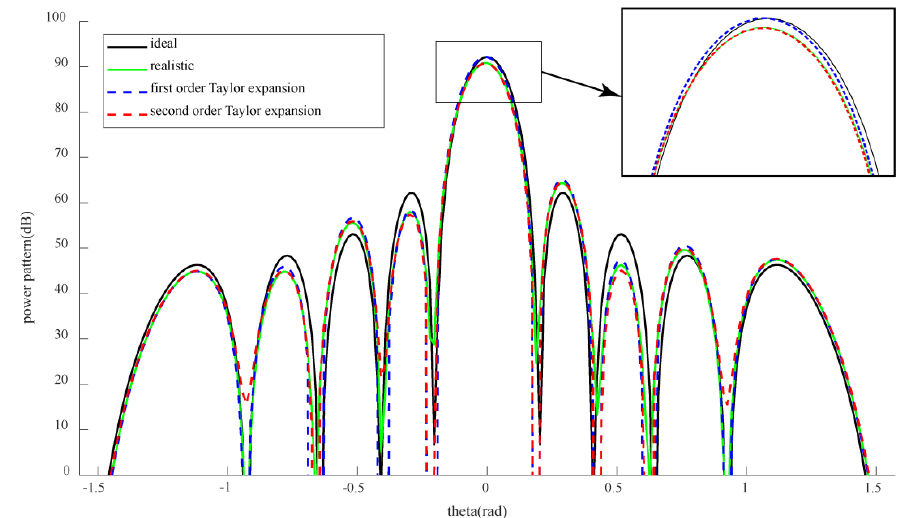
Figure 6. The Taylor expansion in the E plane of the 8 × 8 subarray. The operating frequency is 10 GHz, and the element spacing is 15 mm. The x and y directional position errors of the antenna were ignored, and only the z directional position errors were considered.